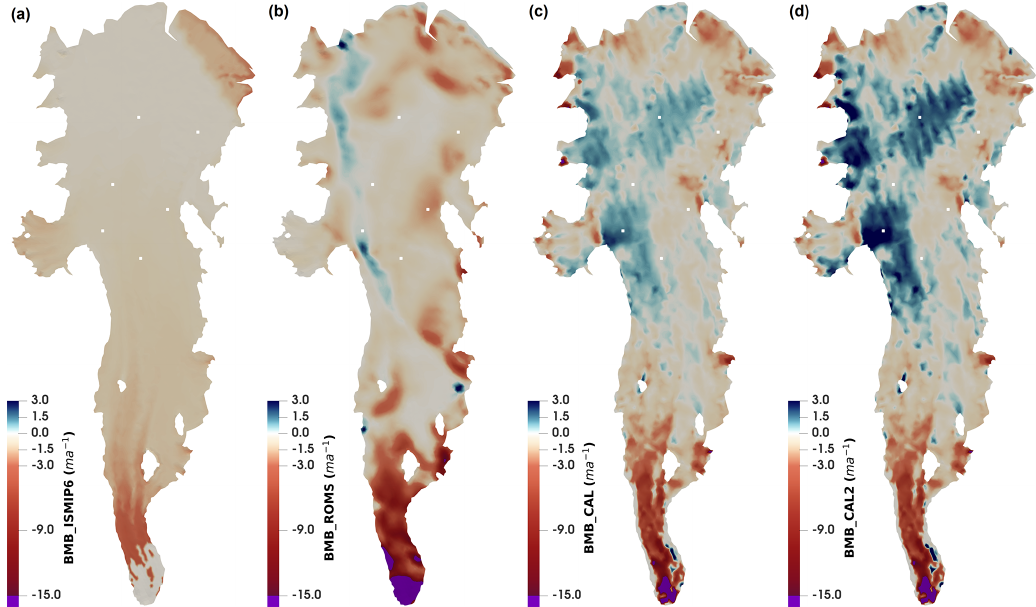
Figure 4. The basal mass balance distributions: (a) BMB_ISMIP6, (b) BMB_ROMS, (c) BMB_CAL and (d) BMB_CAL2. Negative implies basal melting, and positive implies freezing. White dots are the locations of AM01–AM06 boreholes, as shown in Fig. 1. Non-linear colour scales are used to cover the large melting rates. Areas with a melting rate greater than 15ma − 1 are represented by purple, with maximum melting rates exceeding 40ma − 1 for some